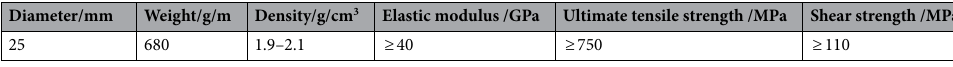
Table 3. Parameters for the fiberglass